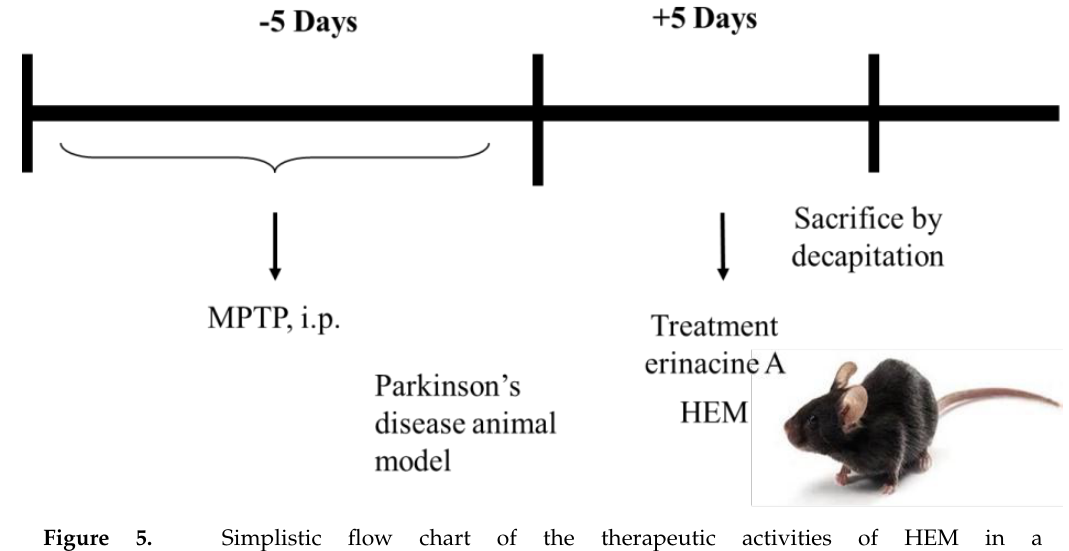
Figure 5. Simplistic flow chart of the therapeutic activities of HEM in a 1-methyl-4-phenyl-1,2,3,6-tetrahydropyridine (MPTP)-treated animal model.